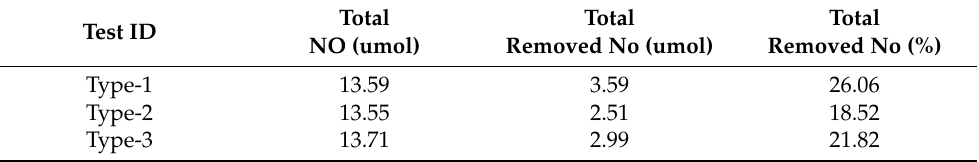
Figure 7. Variation of NOx concentrations during the bed flow photo reactor experiment. Table 6. NO reduction and reduction efficiency of bed flow photo